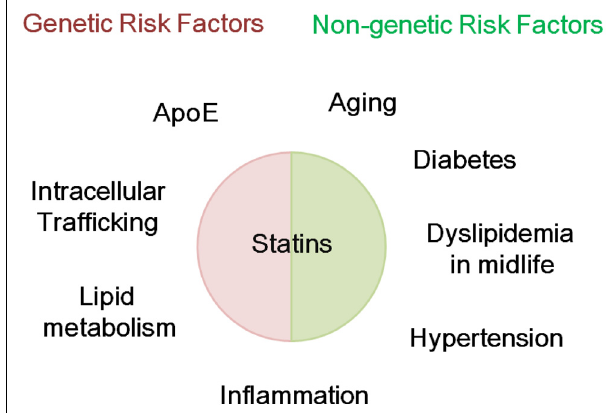
FIGURE 1 | Possible modification genetic and non-genetic risk factors forAD by statins. Statins might modify genetic and non-genetic risk factors for Alzheimer’s disease (AD). Genetic risk factors for AD include apolipoprotein E and genes involved in intracellular trafficking, lipid metabolism, and inflammation. Non-genetic risk factors include aging, diabetes, dyslipidemia in midlife, hypertension, and